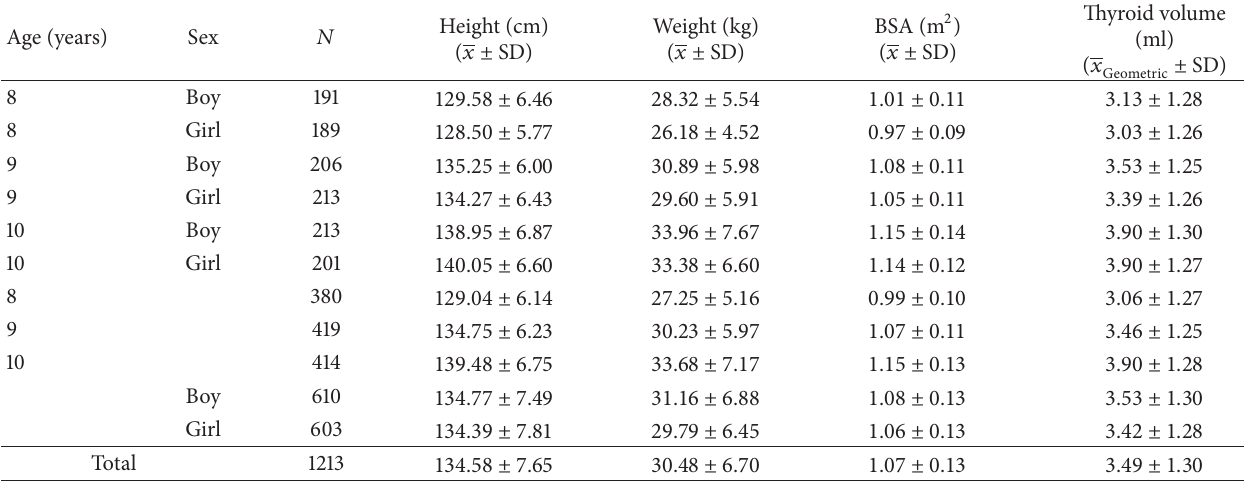
Table 1: Descriptive statistics of schoolchildren participating in study.